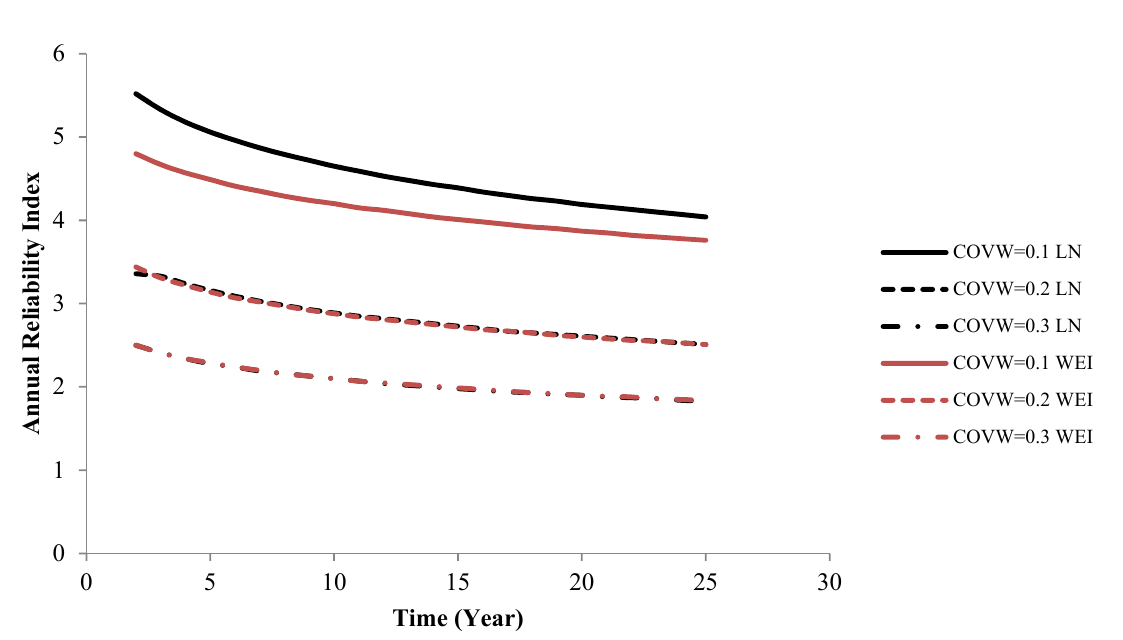
Figure 7. Annual reliability index for different uncertainty models for X W . Test D21 T150 R = − 1.